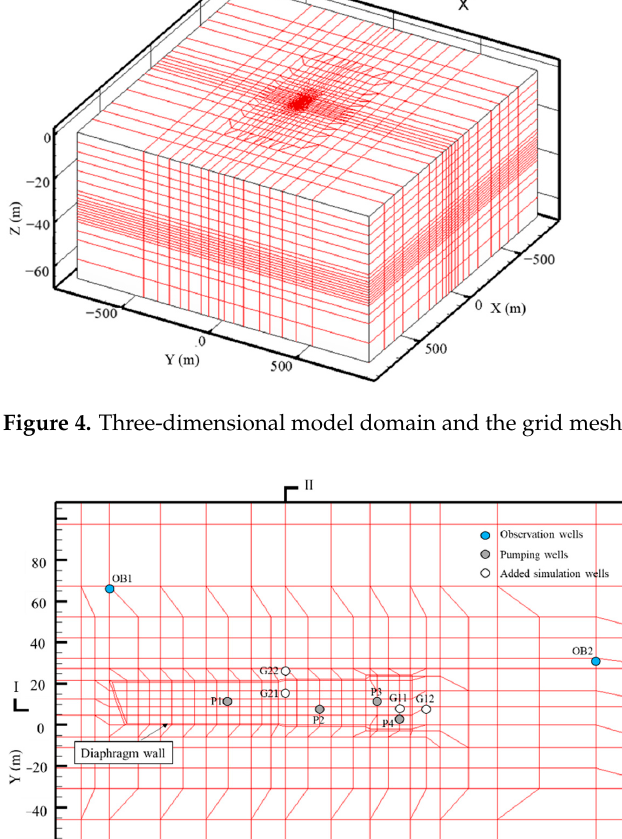
Figure 6. Profile of section II-II.